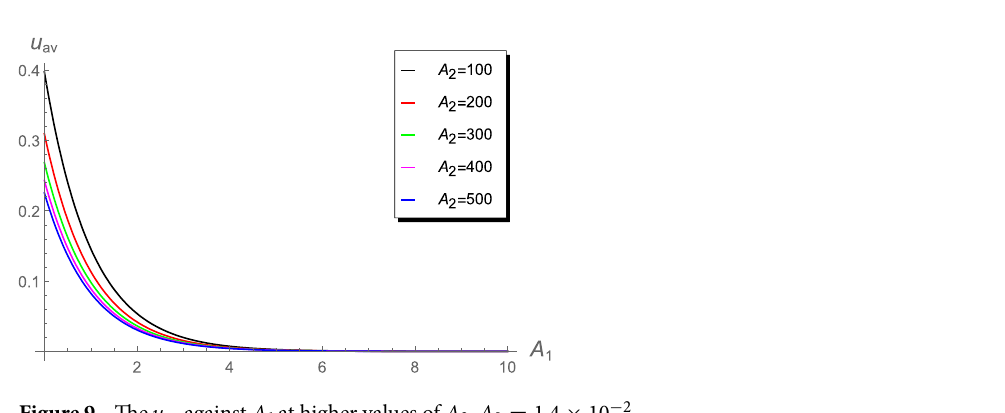
Figure 9. The u av against A 1 at higher values of A 2 , A 0